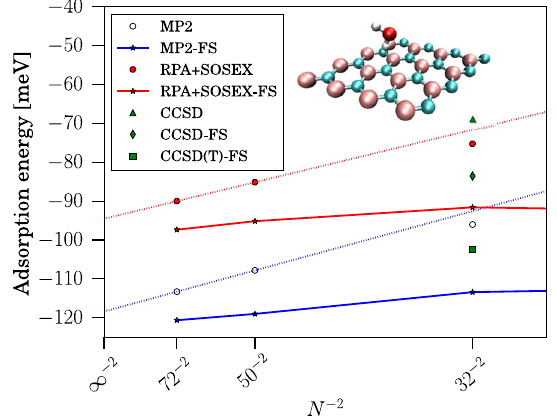
FIG. 4. Adsorption energy of a single water molecule on an h -BN sheet. The energies are retrieved as a function of atoms in the sheet using MP2, RPA þ SOSEX, CCSD, and CCSD(T) theory. FS indicates that finite-size corrections are included. The results have been obtained using pseudized aug-cc-pVTZ basis sets and corrected for basis-set superposition errors using counterpoise